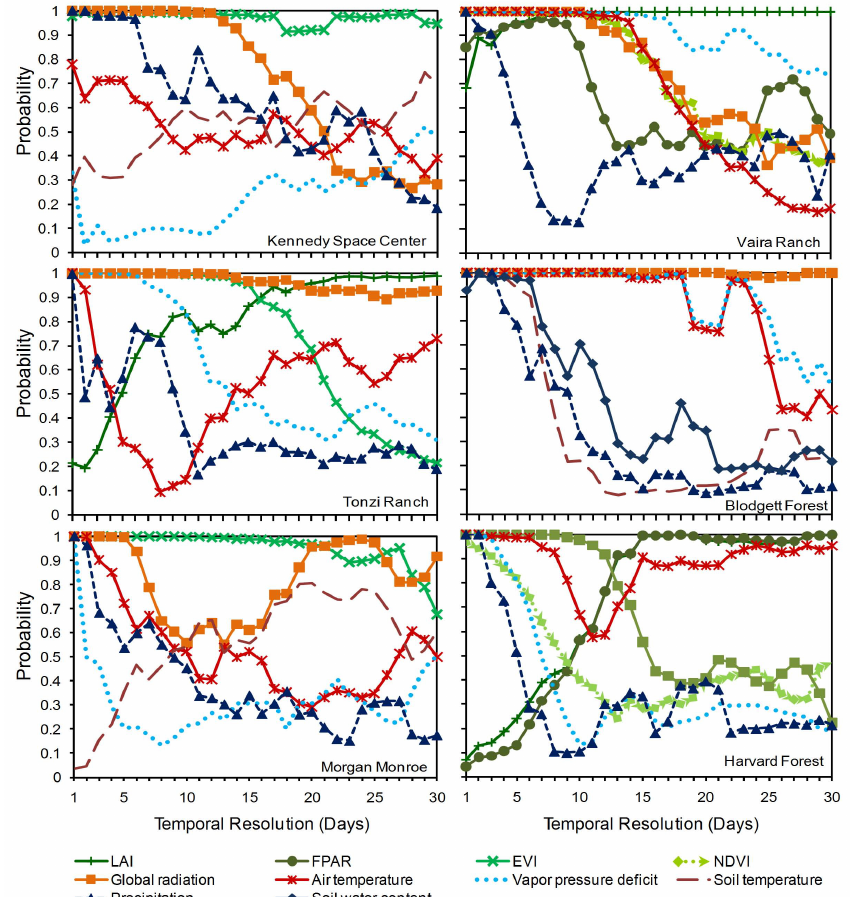
Fig. 4. Posterior probability of covariates at 1-day to 30-day temporal scales for examined AmeriFlux study sites (see Sect. 3.4 and Eq. 12). The probabilities across temporal resolutions have been smoothed using a three day running average, and only covariates selected in the best GR model at the daily, 8-day and/or monthly scale are presented for each